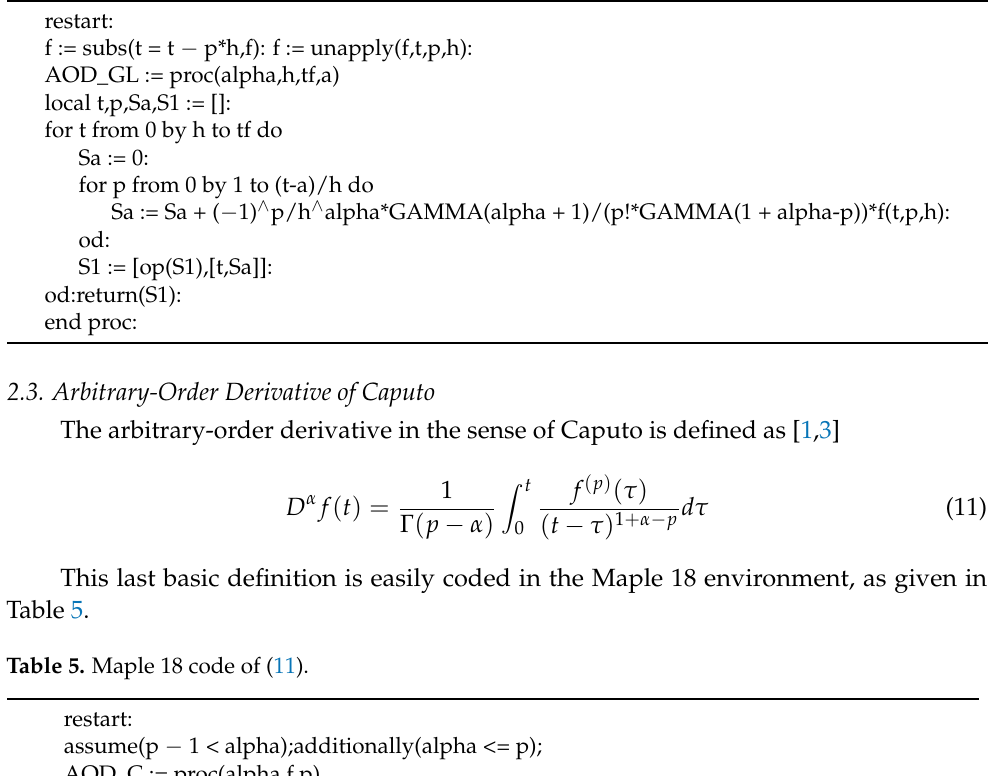
Table 4. Maple 18 code of (9).